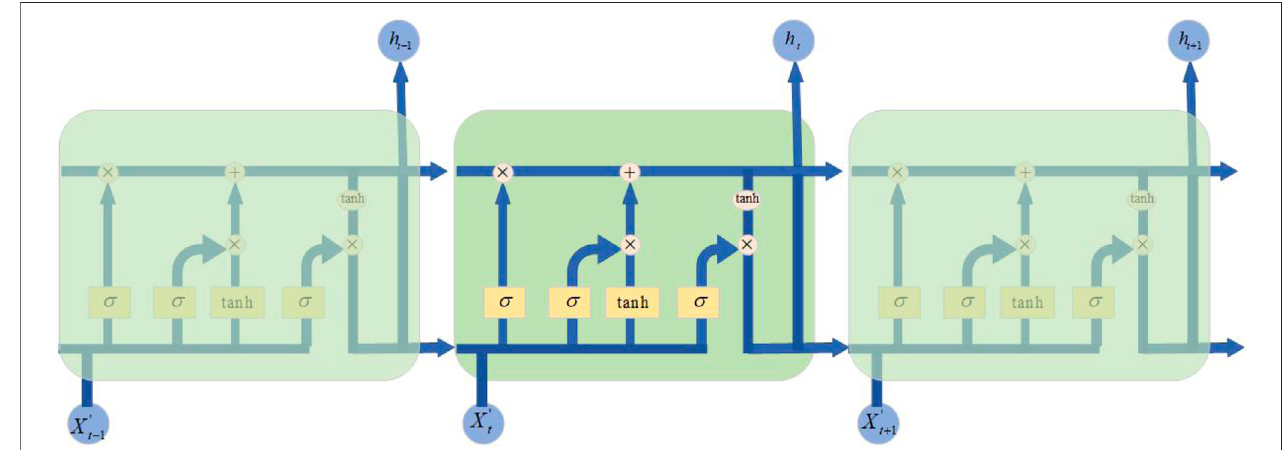
FIGURE 3 | The architecture of GRU